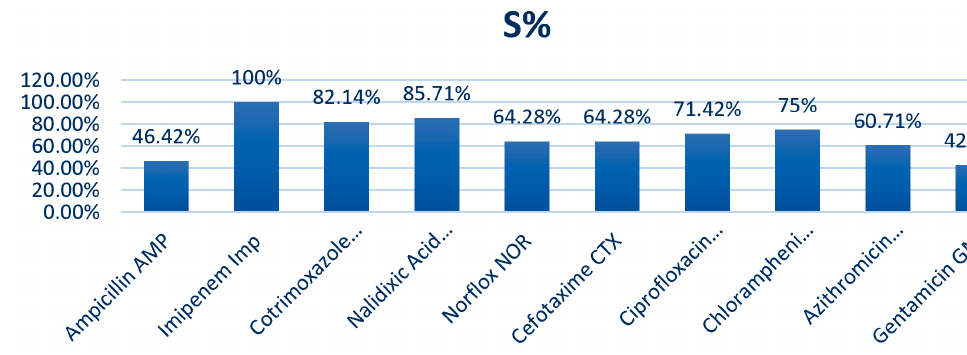
Fig. 8. Antimicrobial sensitivity of ETEC Strain of E.coli (N=28)